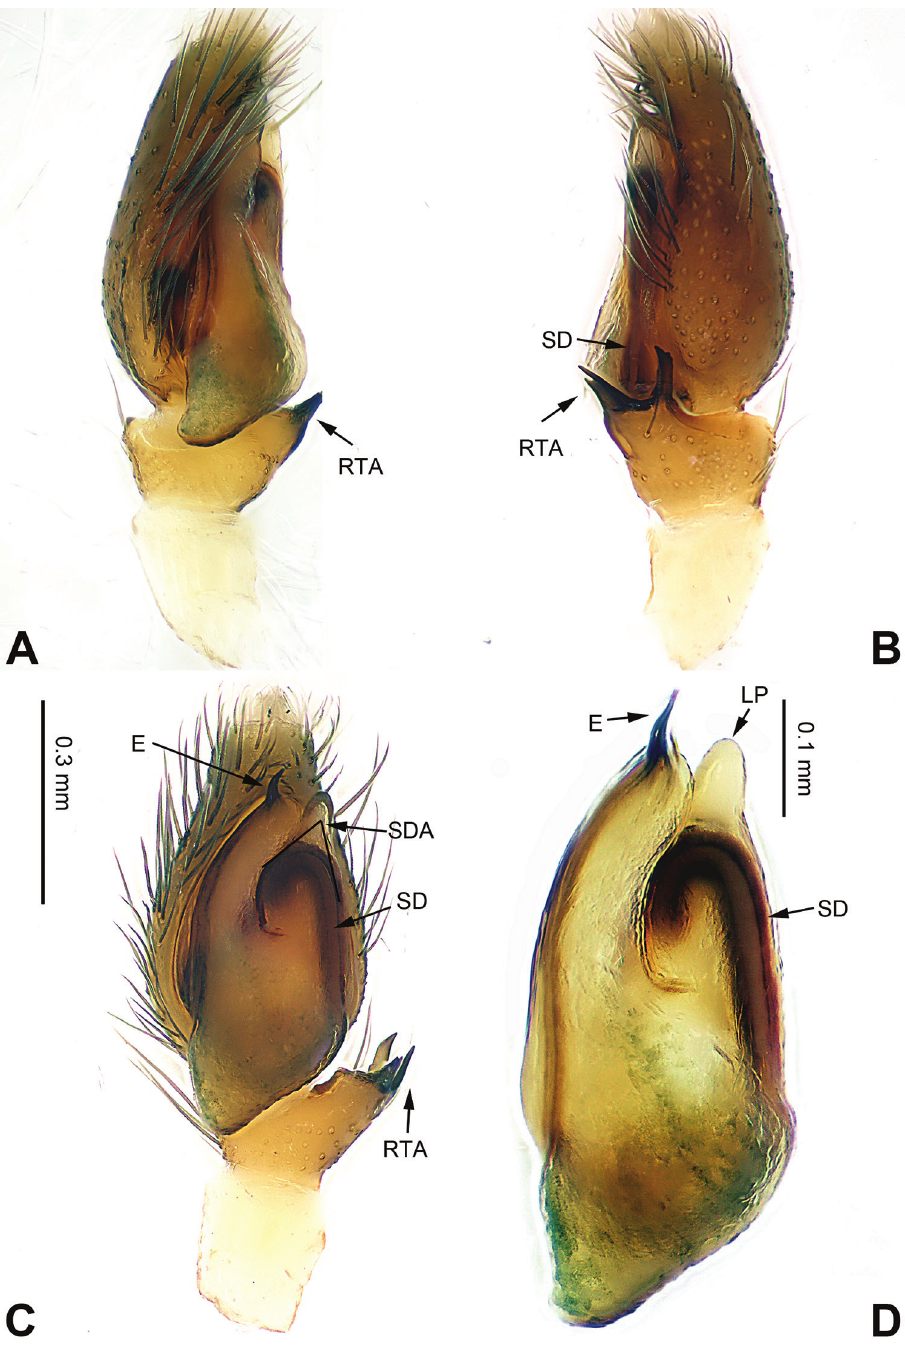
Figure 34. Palp of Phintella sancha sp. n., male holotype. A prolateral B retrolateral C ventral D bulb, ventral. Scale bar equal for A–C